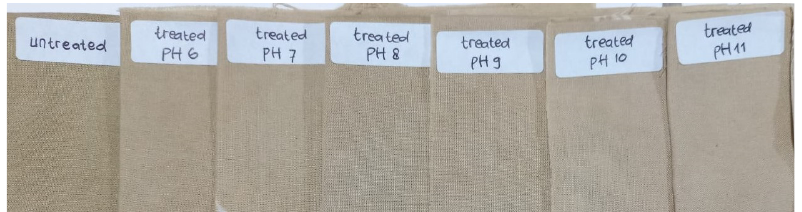
Figure 9. The effect of the in situ ZnO NPs immobilization process at various pH on the color quality of ND-colored Batik fabric. Table 3. The value of L*, a*, and b* of untreated and ZnO NPs-treated ND-colored Batik fabric.